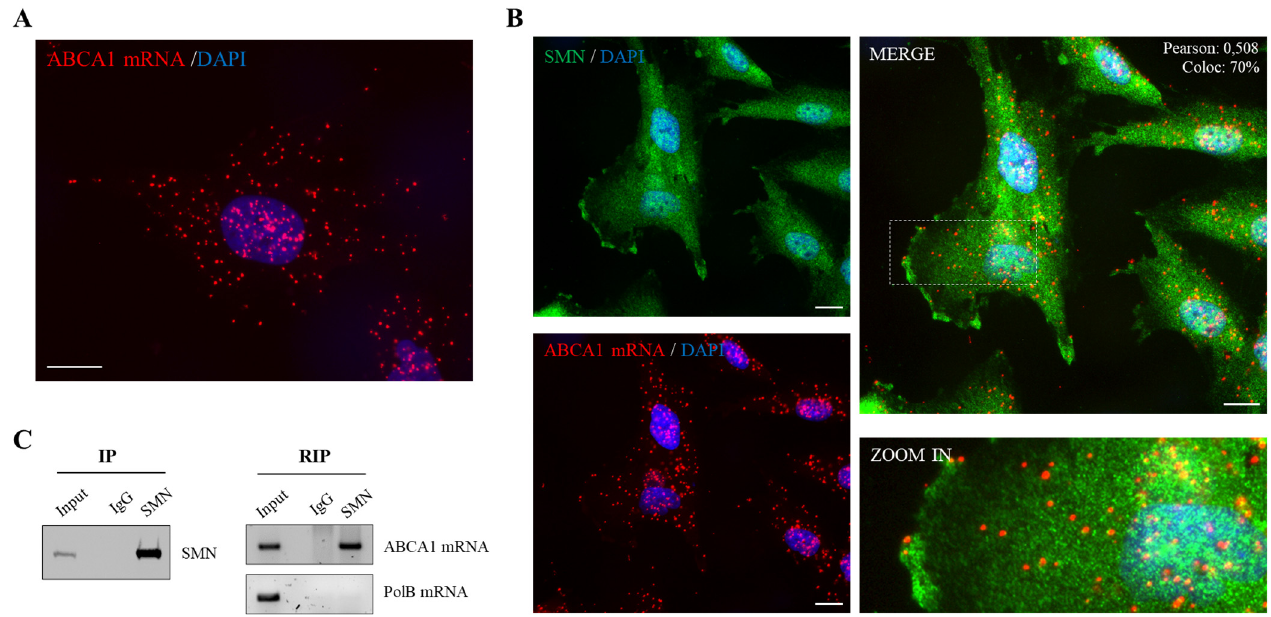
Figure 1. SMN associates to ABCA1 mRNA. ( A ) Representative image of human fibroblasts subjected to a padlock assay targeting ABCA1 mRNA. AlexaFluor 595-labelled probe allowed the detection of amplicons (red dots). Nuclei were labelled with DAPI (blue). Scale bars, 10 µm. ( B ) Fibroblasts were subjected to a combination of SMN immunostaining (green) and padlock assay targeting ABCA1 mRNA (red), and then were imaged via high-resolution epifluorescence microscopy. Nuclei were stained with DAPI (blue). Scale bar, 10 µm. Higher magnification of the boxed area (ZOOM IN) reveals some of the overlapped fluorescent signals (yellow dots). The classical Pearson coefficient of the pixel–intensity correlation and the percentage of ABCA1 mRNA (red) colocalizing with SMN (green) were reported in the MERGE panel. ( C ) Cellular extracts were processed for RNA-immunoprecipitation (RIP) assay using SMN monoclonal antibody-conjugated beads. As a negative control, mouse IgG-conjugated beads were used. Immunoblotting validating the efficiency of SMN immunoprecipitation (left panel). ABCA1 mRNA presence in RIP samples was checked semiquantitative RT-PCR (right panel). RT-PCR analysis of DNA Polymerase Beta ( PolB ) mRNA was used as negative control. Panels are representative of three independent